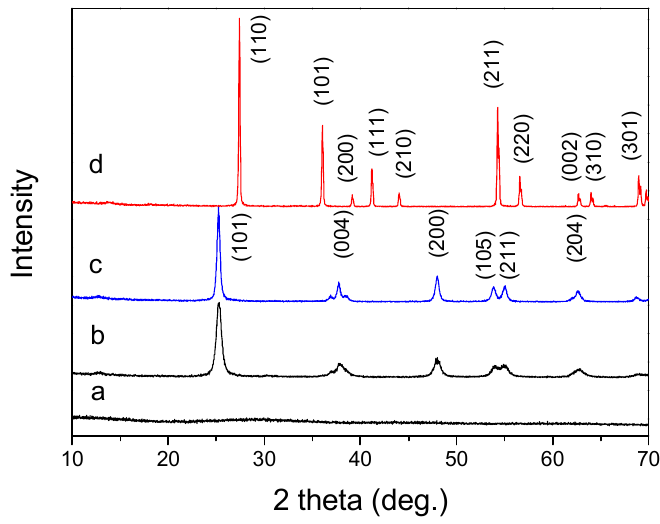
Figure 2. XRD patterns of titanium samples, ( a ) titanium precursor, ( b ) TiO 2 -350, ( c ) TiO 2 -550, ( d ) TiO 2 -800.